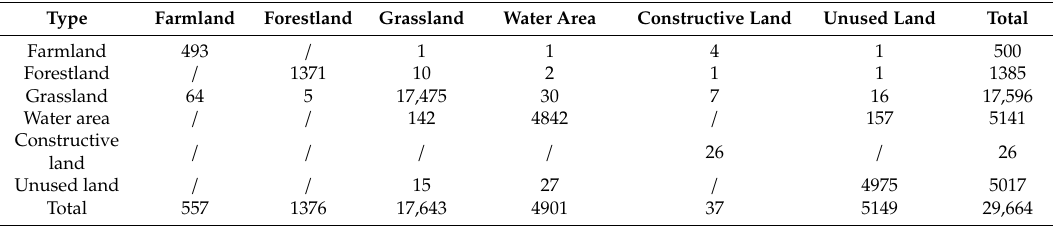
Table 4. Land use change parameters from 1980 to 2015 (km 2